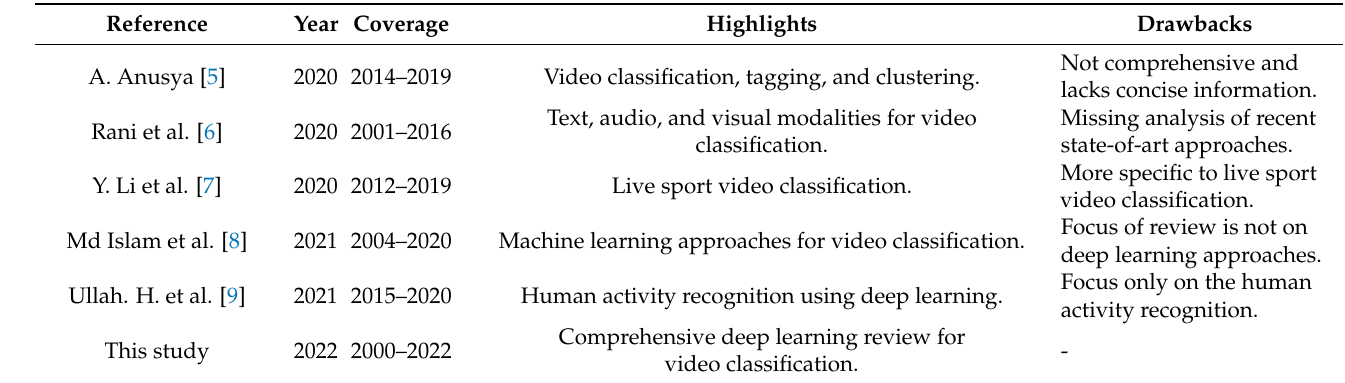
Table 1. Summary of recent related